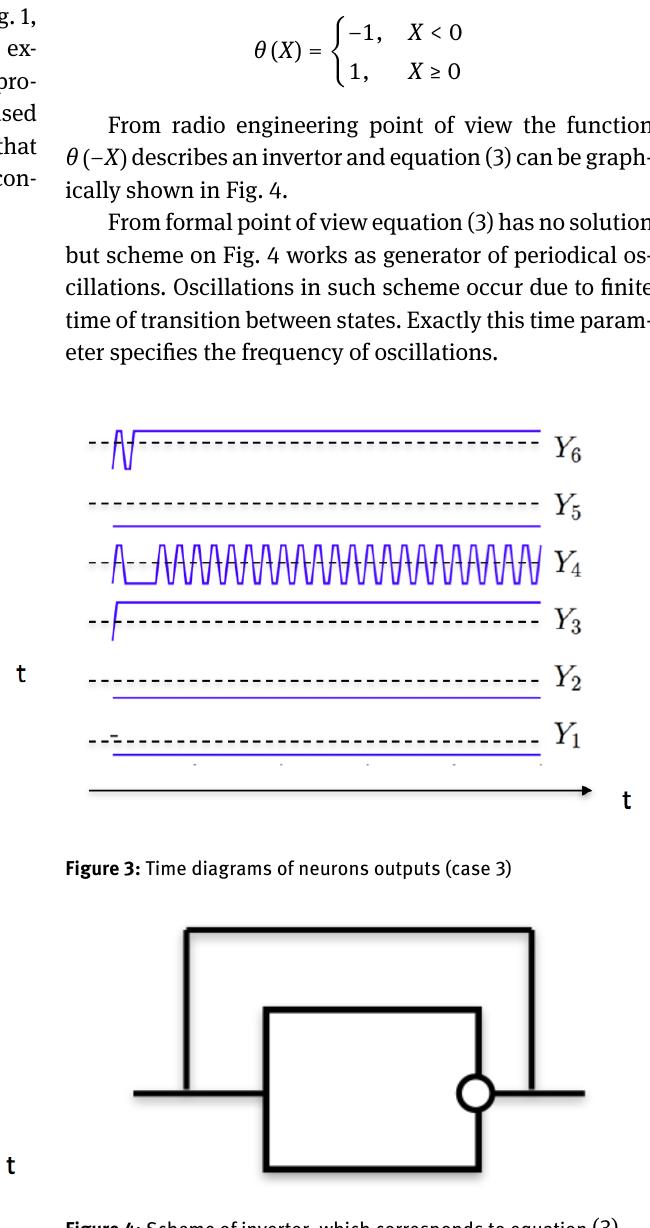
Figure 2: Time diagrams of neurons outputs (case 2)